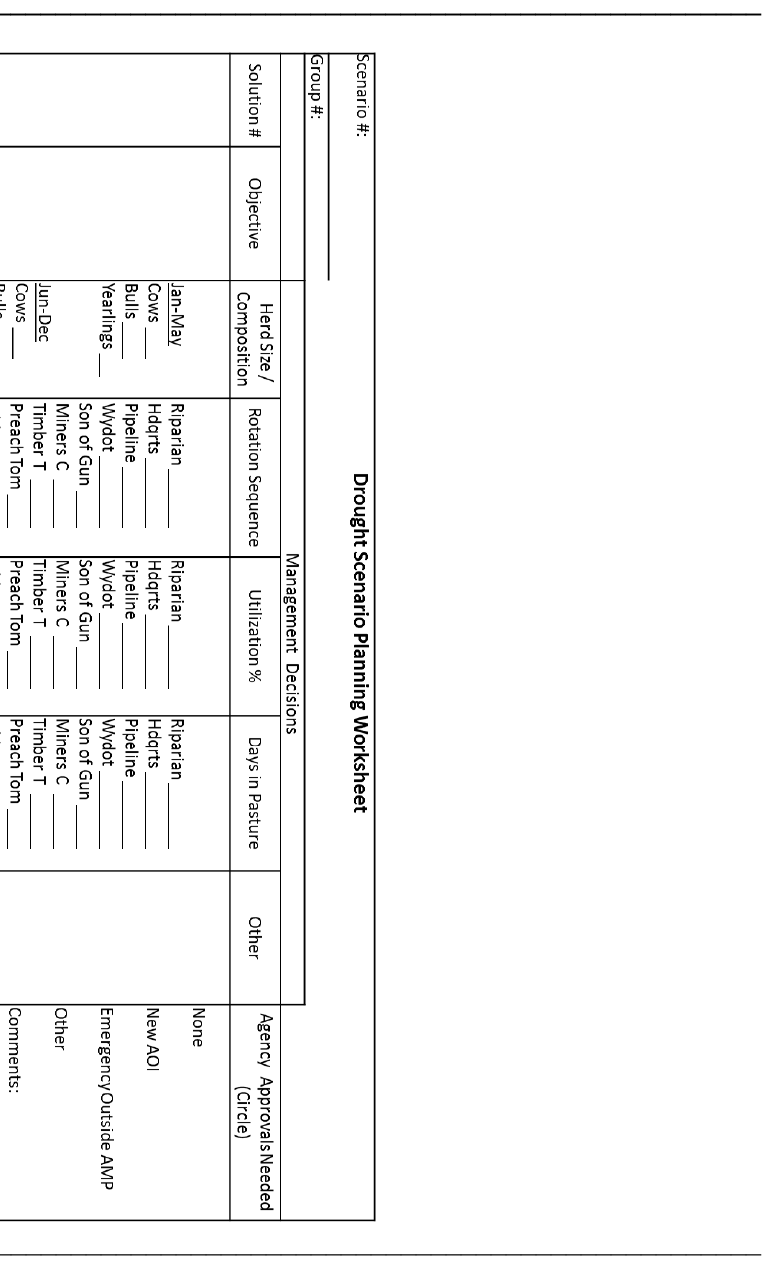
Figure A1.1: Worksheet used during the group exercise for recording a solution to a drought